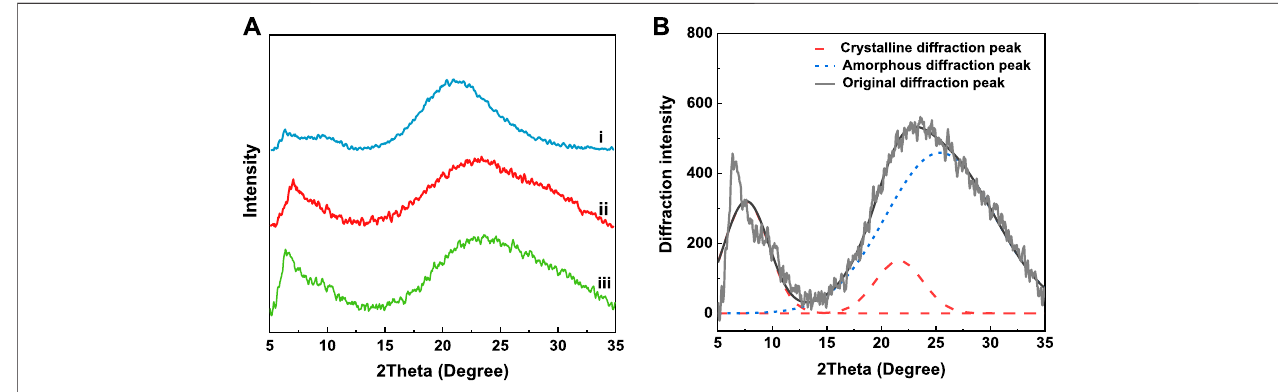
FIGURE 7 | XRD spectrum of samples (A) i: natural wool, ii: K-C, iii: K-M; (B) peak fi tting results of natural wool XRD spectrum.